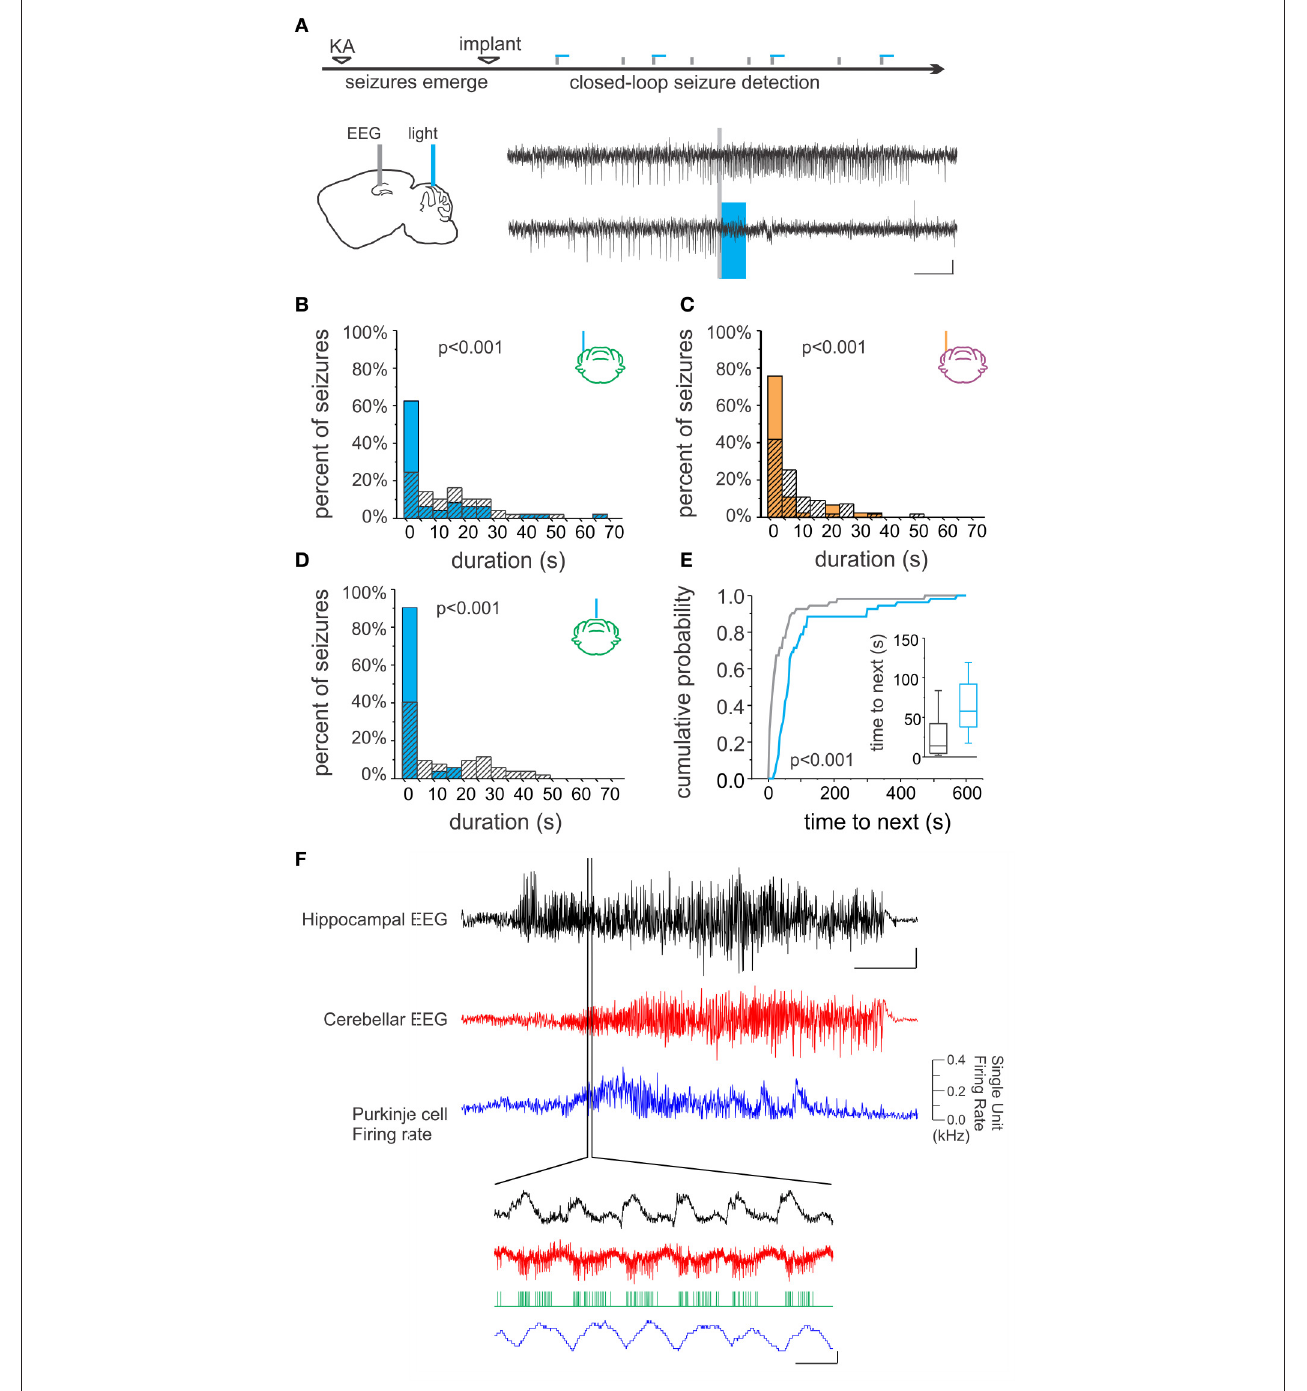
FIGURE 2 | Bidirectional cerebellar-hippocampal connectivity in epilepsy. (A) Intrahippocampal kainate injection induced chronic epilepsy and spontaneous seizures. Seizures were detected online, allowing on-demand optogenetic cerebellar modulation selectively at the time of seizures. Top electrophysiological trace is representative of a detected (gray line) seizure recorded from the hippocampus not receiving optogenetic modulation; bottom trace shows attenuation of hippocampal seizure activity resulting from optogenetic cerebellar modulation (horizontal bar indicates light delivery). Stimulation (B) or inhibition (C) of neurons in the lateral cerebellum or midline vermis (D) significantly reduced hippocampal seizure duration. Vermal stimulation uniquely also significantly increased the time to next seizure, indicating a decrease in seizure frequency (E) . (F) Hippocampal seizure activity (black trace) produced changes in the cerebellar EEG (red trace) and modulated the firing rate of Purkinje cells (blue trace), supporting the bidirectional nature of functional connectivity between the cerebellum and hippocampus. Scale bars: (A) 5s, 0.05mV; (F) Top three traces: 10s; hippocampal EEG: 1mV, cerebellar EEG: 0.5mV. Lower traces: 0.5mV or 0.1kHz change in firing rate, 0.1s. Reproduced with permission from Krook-Magnuson et al.